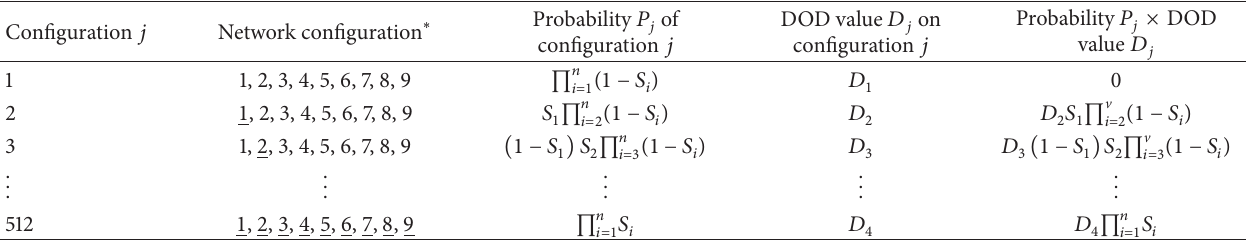
Table 3: Calculation of an example of the Average DOD value.